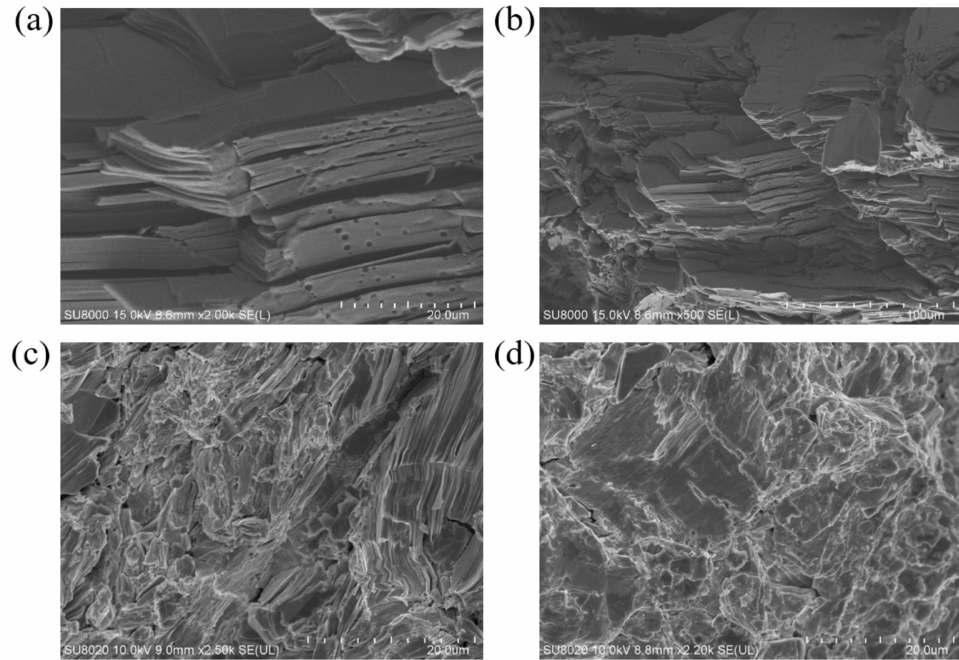
Figure 6. ( a , b ) SEM image of the 10% deformation CHCM specimen; ( c , d ) SEM images of the 30% deformation CHCM specimen, ( c ) high magnification image with the direction parallel to the load axis, ( d ) high magnification image with the direction perpendicular to the load